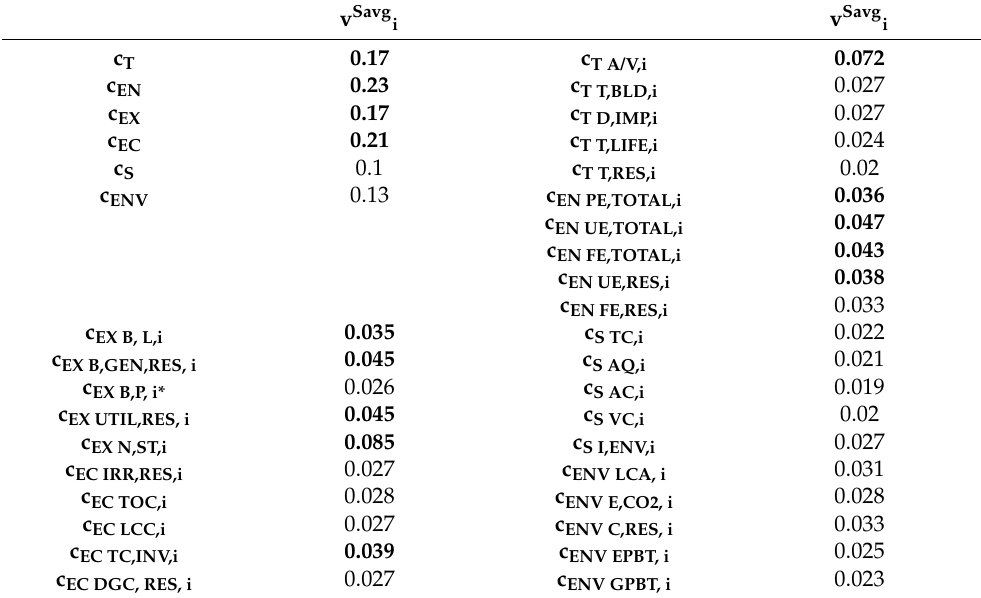
Table 2. Normalized weights determining the importance and relations for individual main criteria and sub-criteria of